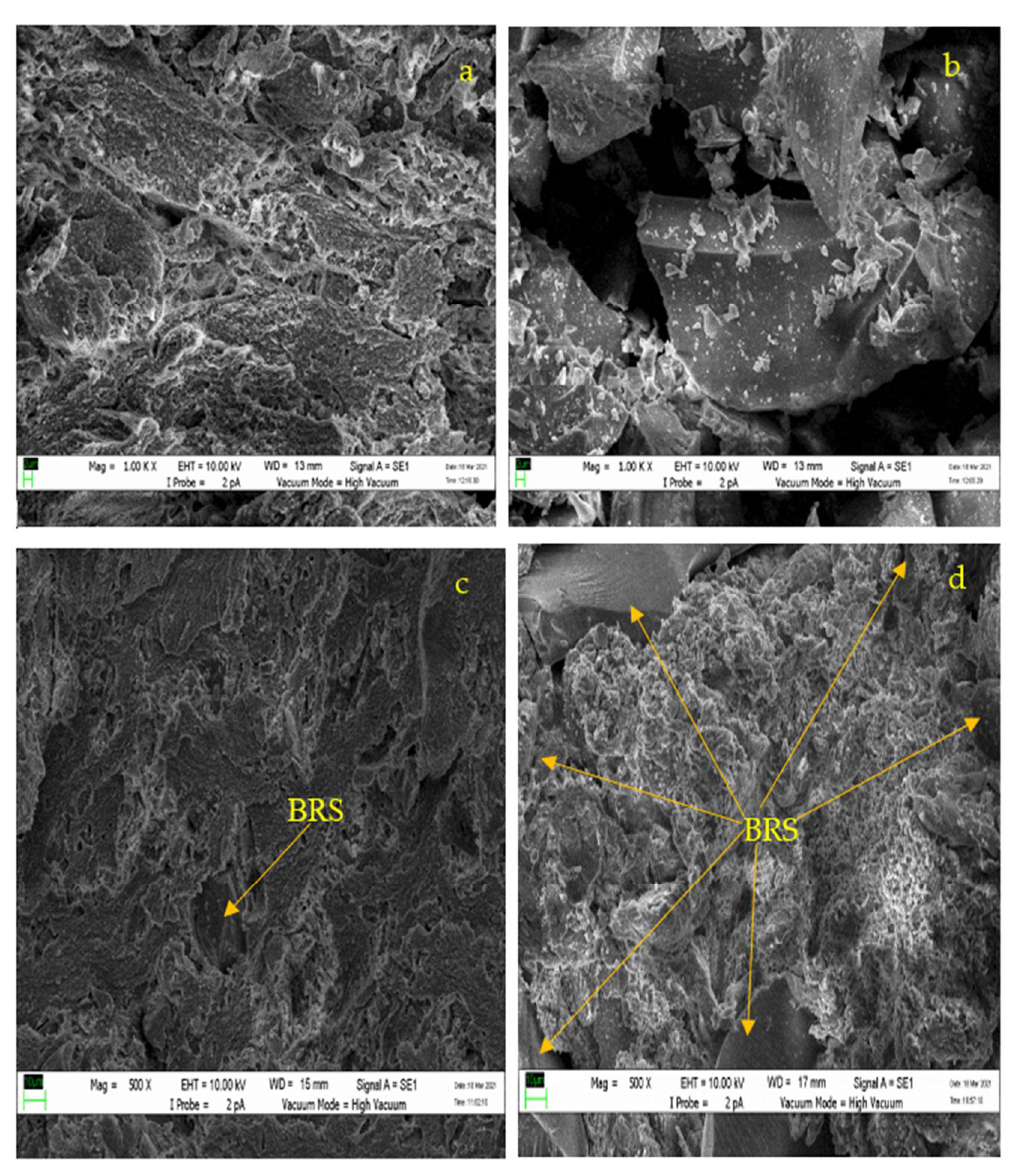
Figure 3. SEM micrographs of ( a ) PTFE, ( b ) recycled BRS powder, ( c ) PTFE/recycled BRS at (at 25 µm BRS) and ( d ) PTFE/recycled BRS composites at (106 µm BRS).